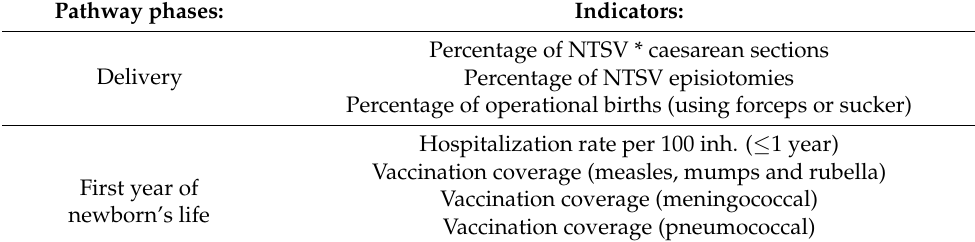
Table 1. Maternity pathway indicators for evaluation. Pathway phases: